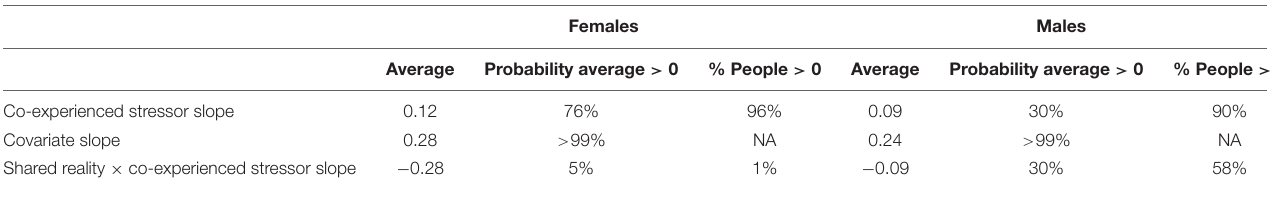
TABLE 2 | Multivariate regression results with shared reality predicting psychological stress.